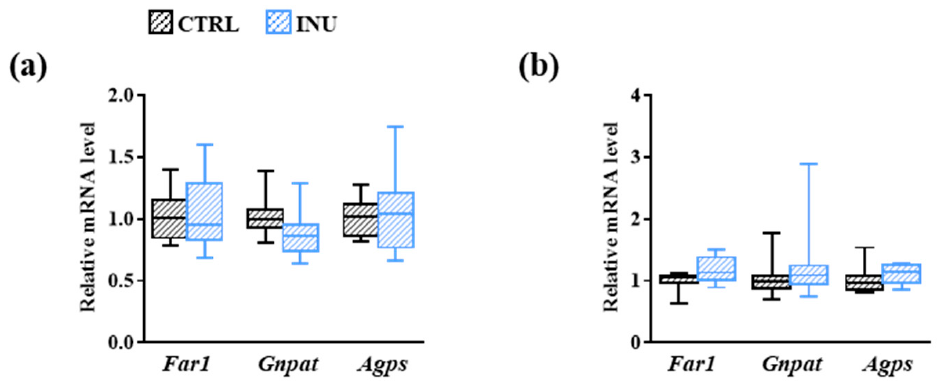
Figure 4. Effect of inulin on the expression of genes encoding enzymes involved in the biosynthesis of plasmalogens. Liver ( a ) and cortex ( b ) expression of genes encoding fatty acyl-CoA reductase 1 ( Far1 ), DHAP-AT/DAP-AT ( Gnpat ), and alkyl-DHAP synthase ( Agps ) in mice fed a control diet or a diet supplemented with inulin. The levels of mRNA were normalized to Hprt mRNA level for calculation of the relative levels of transcripts. mRNA levels are illustrated as fold change. Data are presented in box and whisker plot format (median, min. to max.). Mann–Whitney test for comparison of the level of each mRNA between CTRL and INU mice.